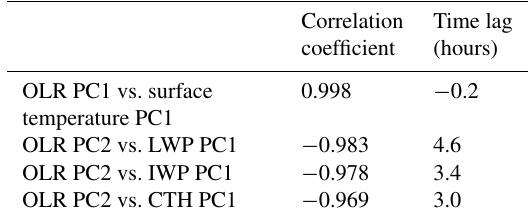
Table 1. Maximum correlation coefficient and time lag at which it occurs from a cross-correlation between principal components (PCs) of modelled outgoing long-wave radiation (OLR) and PCs of modelled surface temperature, cloud liquid water path (LWP), cloud ice water path (IWP) and cloud top height